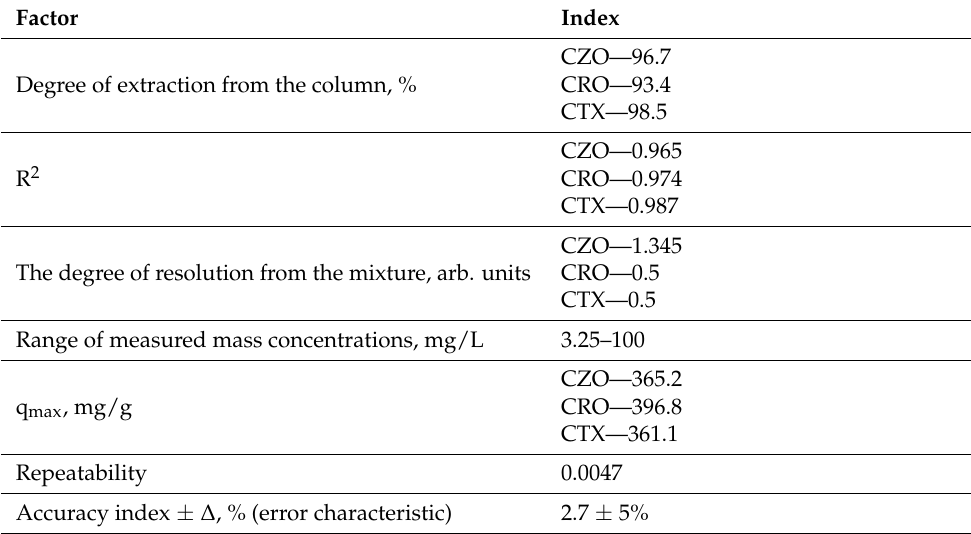
Table 5. Separation of a mixture of antibiotics.